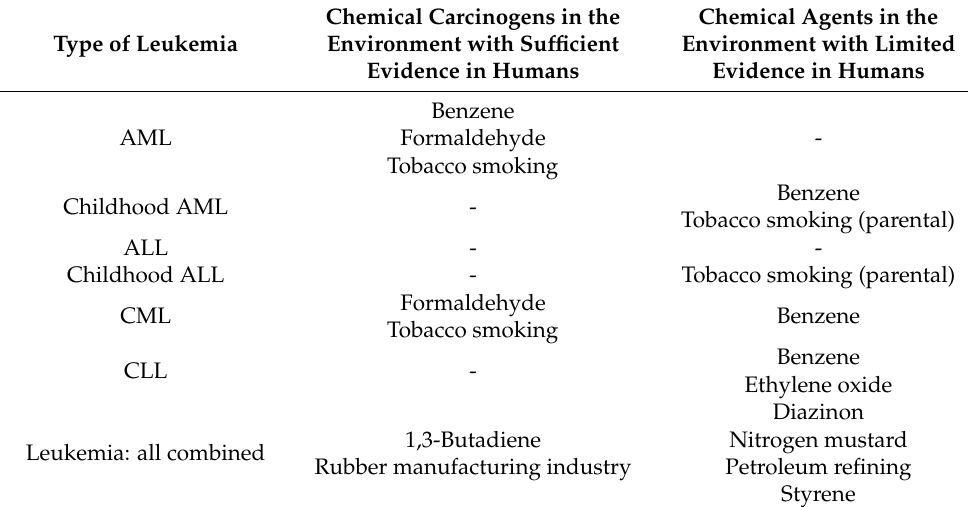
Table 1. Leukemia-inducing chemical carcinogens listed by IARC.